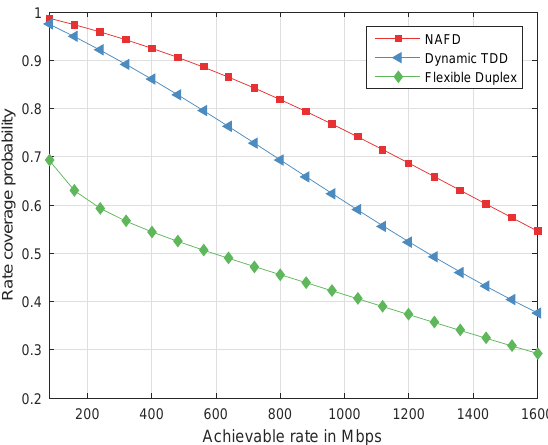
Figure 7. Instantaneous achievable rate performance.